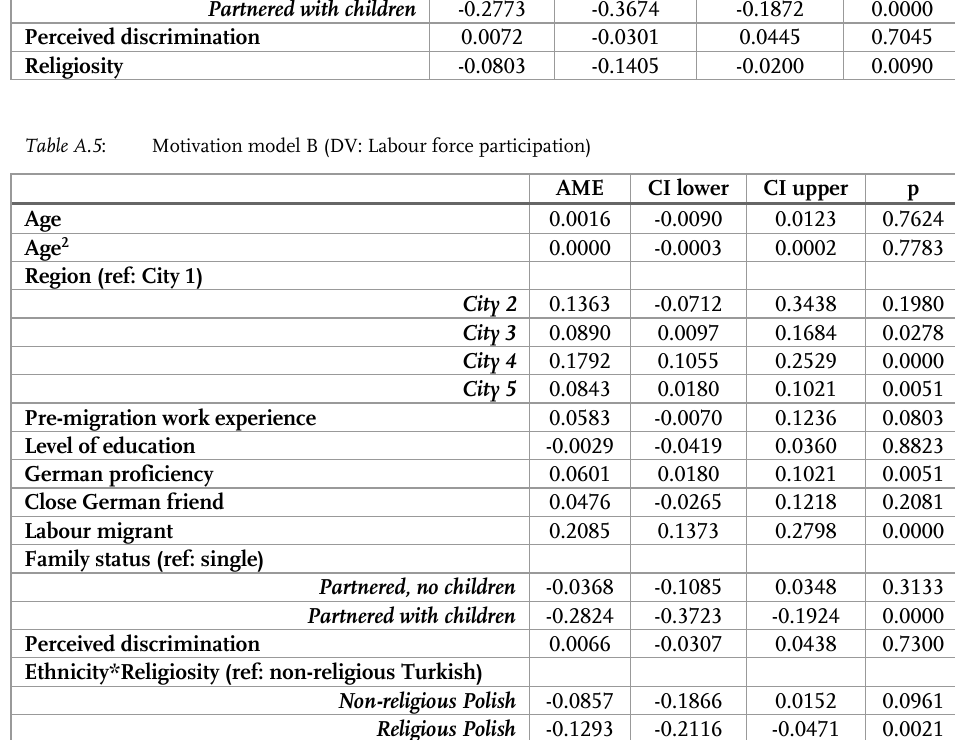
Table A.5 : Motivation model B (DV: Labour force